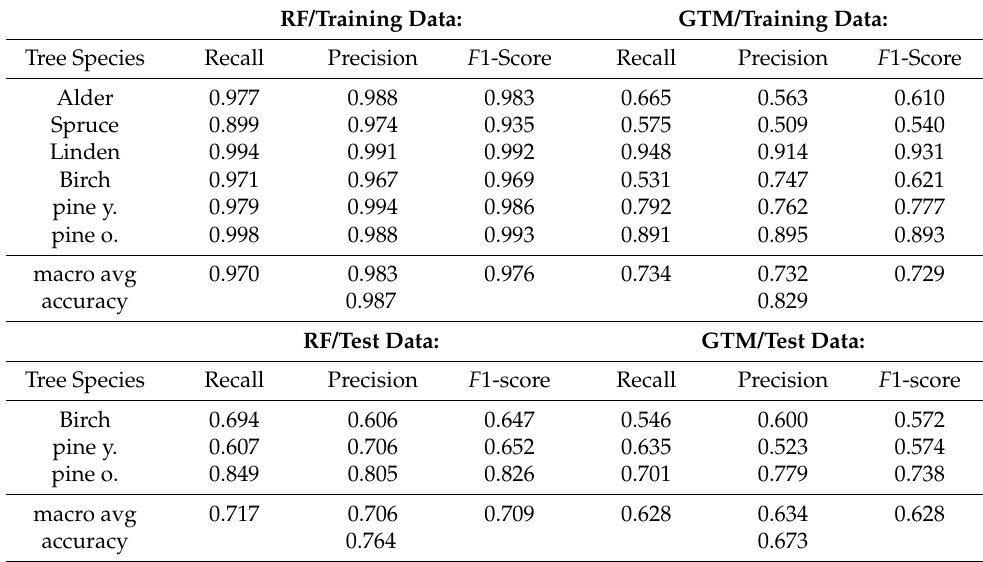
Table 5. Accuracy metrics of automated tree species recognition.